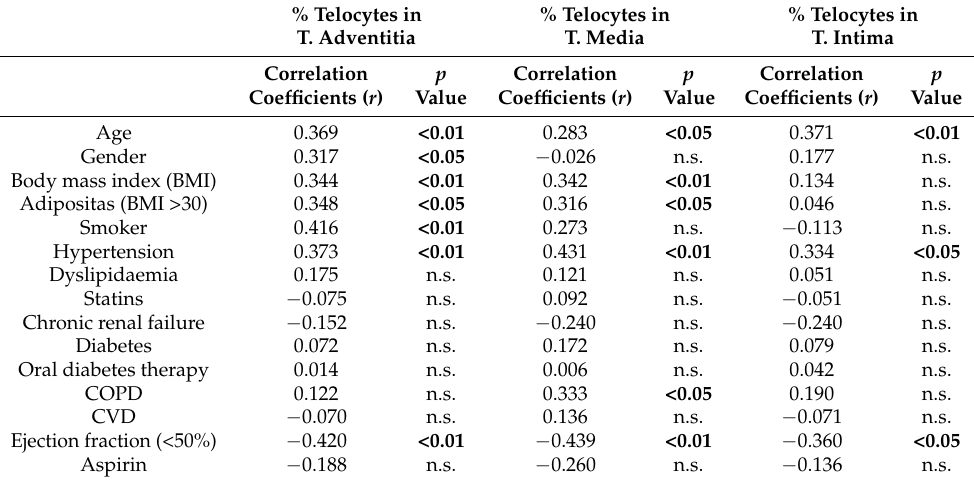
Table 2. Correlation coefficients ( r ) of localization of TCs to patient’s baseline